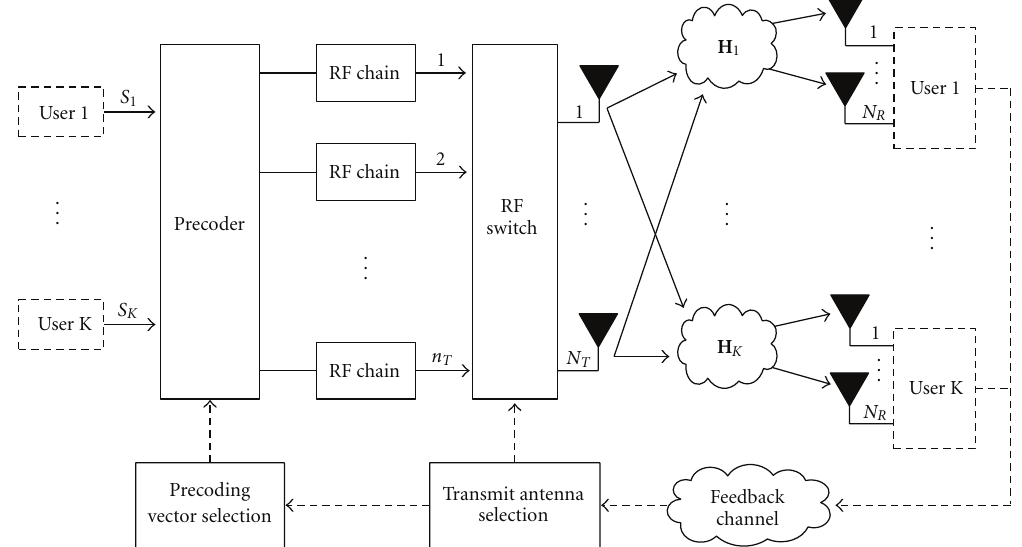
Figure 1: Transmitter structure of the considered hybrid